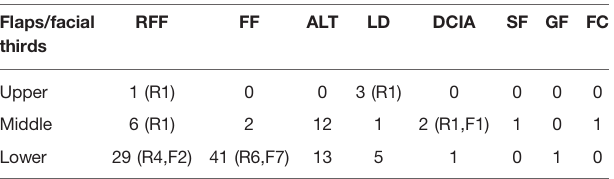
RFF, radial free fl ap; FF, fi bular fl ap; ALT, anterolateral tight fl ap; LD, latissimus dorsi fl ap; DCIA, deep circum fl ex iliac artery bone fl ap; SF, scapular fl ap; GF, gracilis fl ap; FC, medial femoral condile fl ap; R, revised; F, failed fl